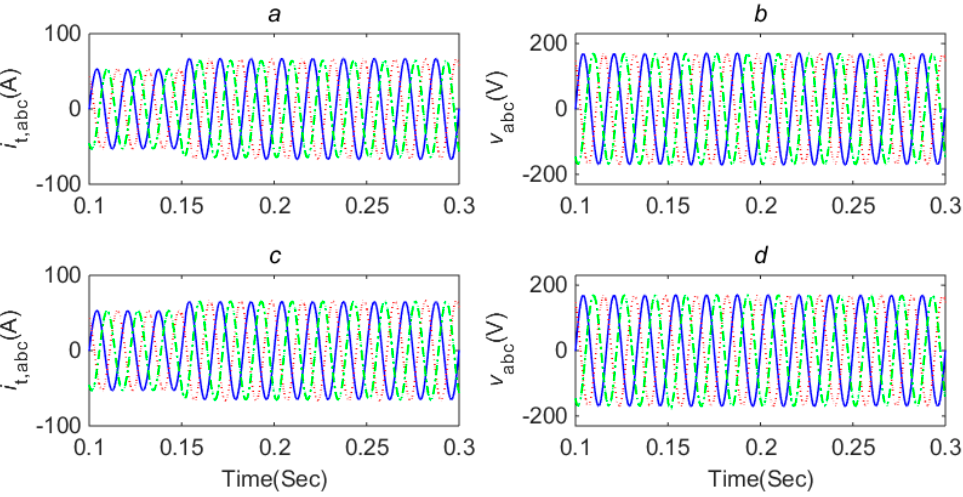
Figure 6. Output current of the main DGu and load voltage (( a , b ) are under RHOSM and ( c , d ) are under AHOSM).